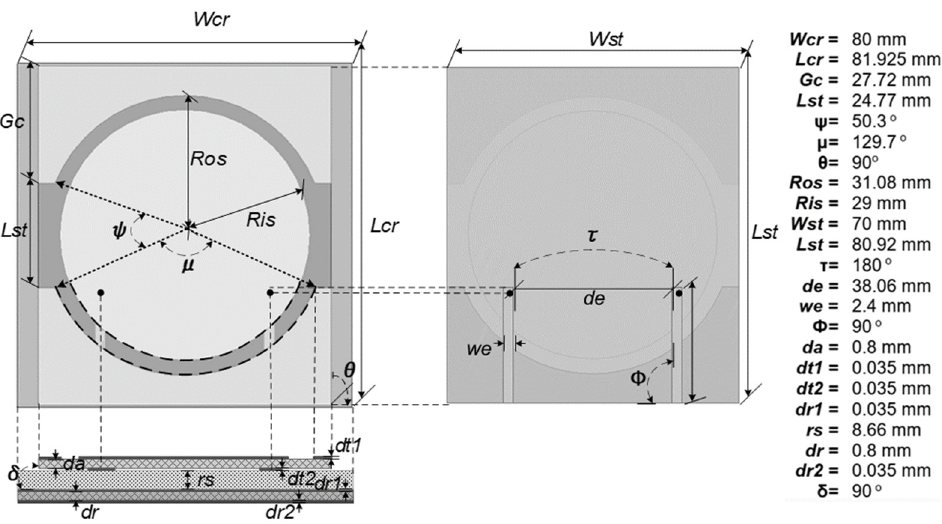
Figure 2. Double slot with dual feed CP Antenna